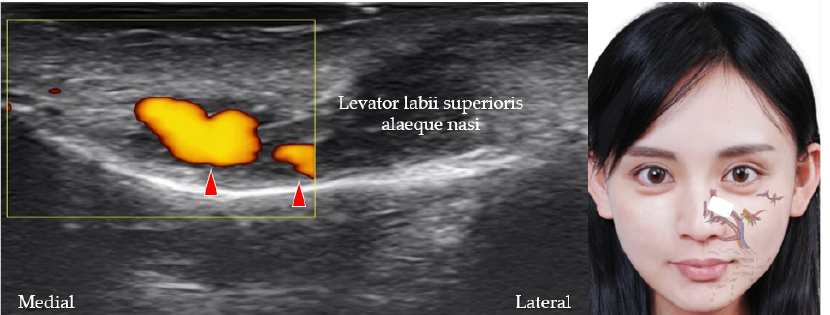
Figure 10. Power Doppler ultrasound imaging of the angular artery (red arrowheads) . White square , footprint of the ultrasound transducer.